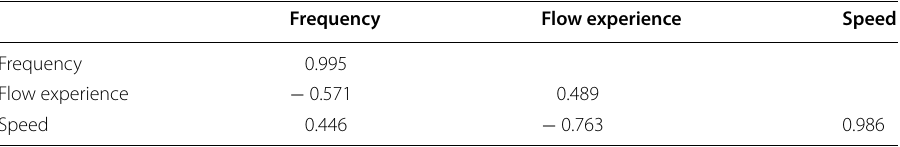
Frequency frequency of students’ action, Speed speed of students’ action